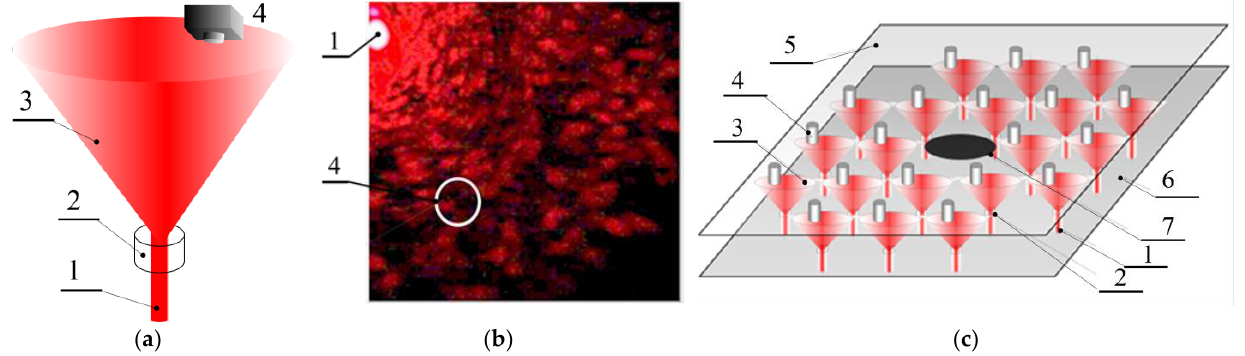
Figure 3. Schematic presentation of the principle of positioning of the detector unit ( a , b ) and multi- channel ABR detection scheme using split laser beam ( c ). 1—laser beam, λ = 645 nm; 2—scattering volume; 3—scattered light field; 4—pin-photodiode; 5—cover of the multichannel chip; 6—base; and 7—shutter.